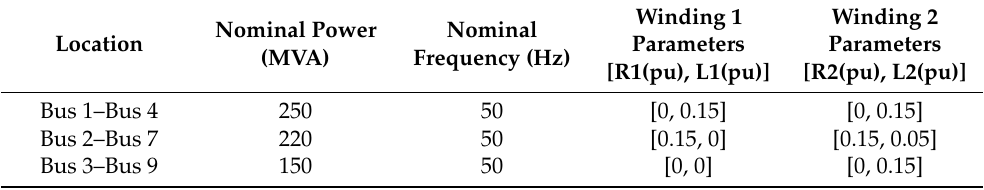
Table A4. The parameters of the transformers.